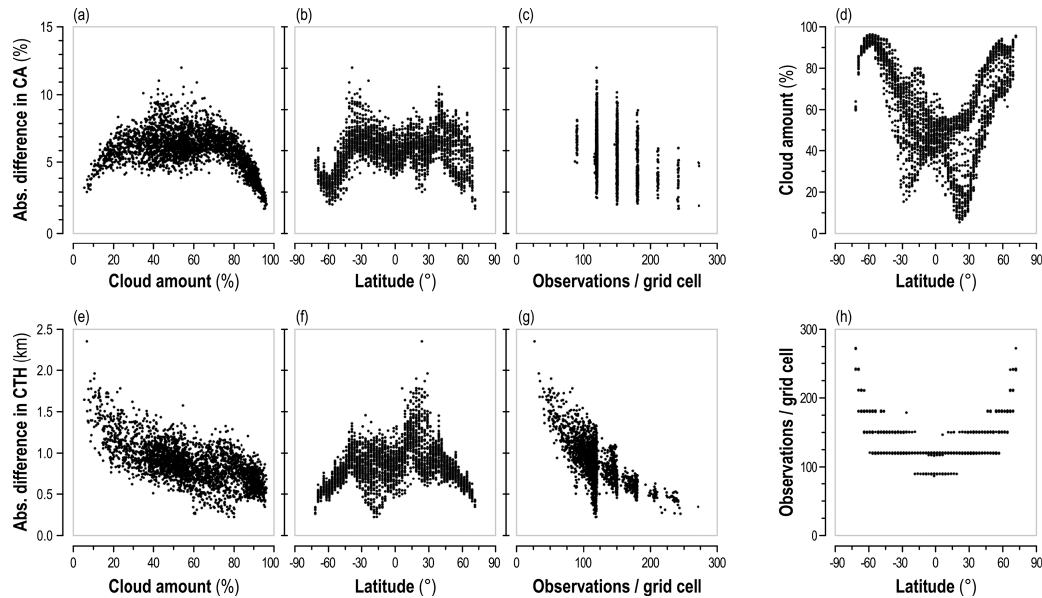
Figure 3. The relation between the mean annual difference in cloud amount (a–c) , and cloud top height (e–g) between n day and 1d revisit climatologies, and: mean cloud amount (a, e) , latitude (b, f) , and the number of observations in the 1d revisit scenario (c, g) . For reference, cloud amount in relation to latitude (d) , and the number of observations (h) is shown. Data refer to the simulated 2.5 ◦ resolution CALIPSO dataset. Table 3. Cloud amount (%) for simulated CALIPSO-like scenarios, calculated for a single year and different locations (top rows), and multiple years at a single location (bottom rows). The table refers to results obtained at 1 ◦ spatial resolution. See text for details. Grid box location; actual 16d revisit location within 1d year day range for all range (%) revisit possible days Single year, many locations 16.5 ◦ N, 22.5 ◦ E;